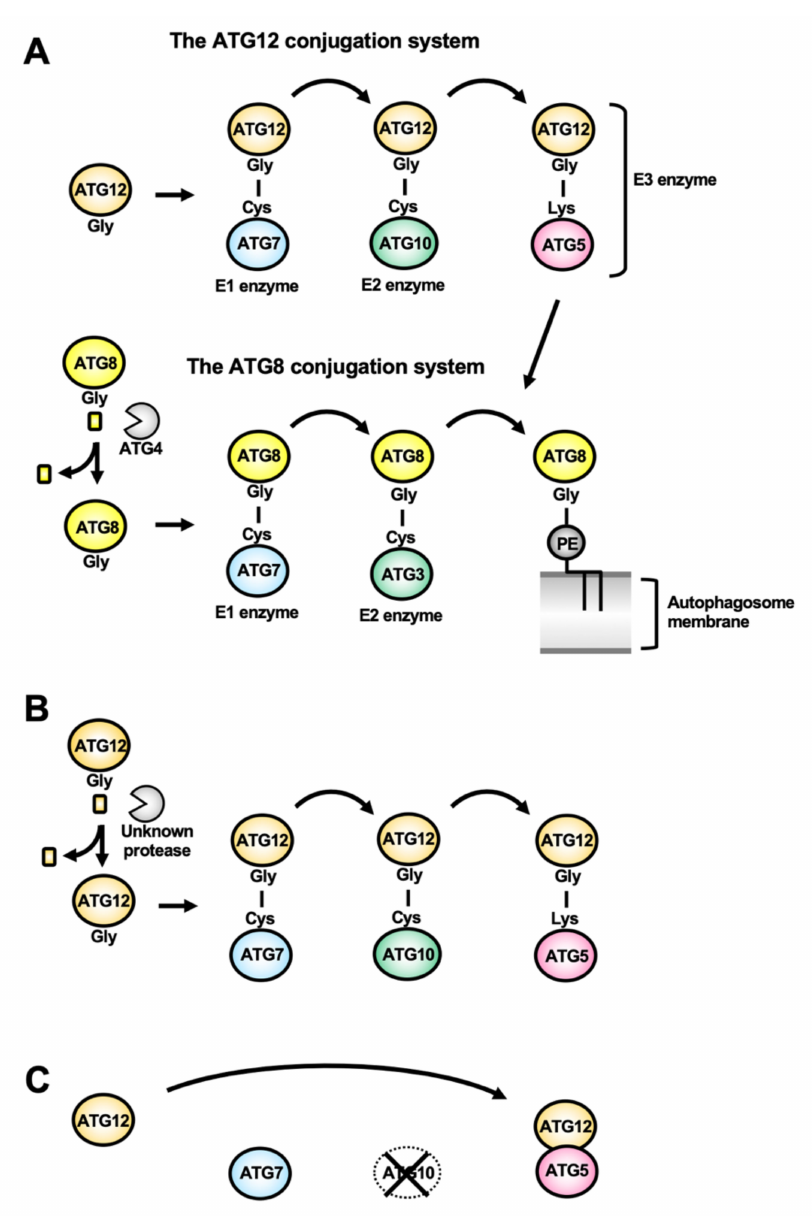
Figure 4. The two ubiquitin-like conjugation systems in autophagy and unique features of the ATG12 system in parasitic protists. ( A ) The ubiquitin-like reactions of ATG12 and ATG8 conjugation as found in most eukaryotes. A ubiquitin-like protein, ATG12, conjugates with ATG5 between the Gly residue at its most C-terminal in ATG12, and the acceptor Lys residue in ATG5. This is catalyzed by ATG7 (E1 enzyme) and ATG10 (E2 enzyme). ATG8, which is also a ubiquitin-like protein, undergoes a C-terminal processing by the ATG4 protease to expose a Gly residue. ATG8 can then be conjugated with the membrane-embedded lipid phosphatidylethanolamine (PE). This is catalyzed by ATG7 (E1 enzyme), ATG3 (E2 enzyme), and the ATG12–ATG5 conjugate (E3 enzyme). ( B ) The ATG12 conjugation system in Leishmania major . LmATG12 has a C-terminal tail like ATG8 homologs. It was demonstrated that a recombinant LmATG12 terminating with a Gly can conjugate with LmATG5. However, the protease involved in the processing of LmATG12 has not been identified. ( C ) The non-covalent ATG12-ATG5 complex in Apicomplexa. Apicomplexan parasites lost the ubiquitin-like reactions for ATG12. They do not have a ATG10 homolog and their ATG12 homolog has lost the C- terminal Gly residue. Instead, apicomplexan ATG12 forms a complex with ATG5 via a non-covalent interaction, and the complex acts as the E3 enzyme for ATG8